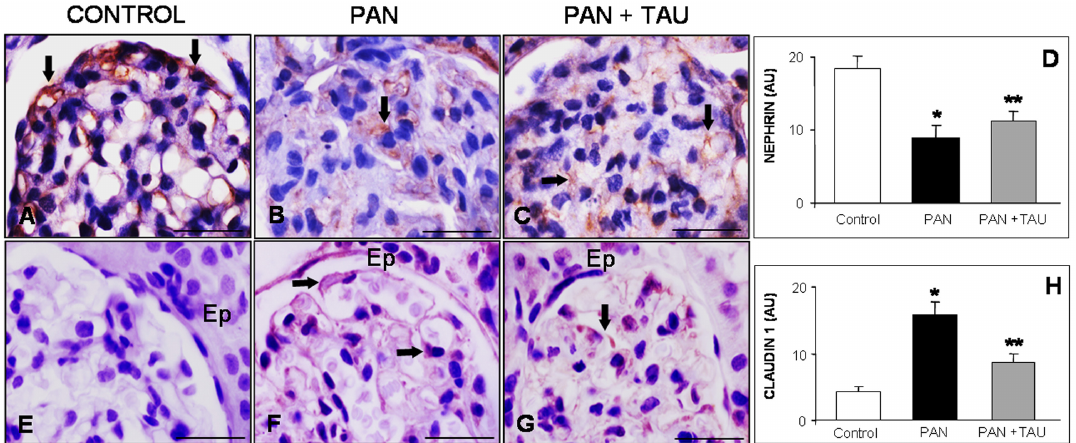
Figure 2. Glomerular cytoskeletal markers. ( A – C ) Nephrin and ( E – G ) claudin 1 in PAN nephrotic rats are reversed by TAU taurine pre-treatment. Arrows indicate strong nephrin immunostaining in ( A ) control, ( B ) scattered in PAN group, and ( C ) condensed after TAU supply. Claudin 1 staining was ( E ) absent in control rats, ( F ) evident (arrows) in glomeruli and epithelial parietal (Ep) cells in PAN group, and ( G ) weak in TAU pre-treated rats. Bar represents 20 µm. Quantitative evaluation of ( D ) nephrin and ( H ) claudin 1 immunostainings in glomeruli are expressed as arbitrary units. * p < 0.05 statistically significant versus control group; ** p < 0.05 significant versus PAN group.